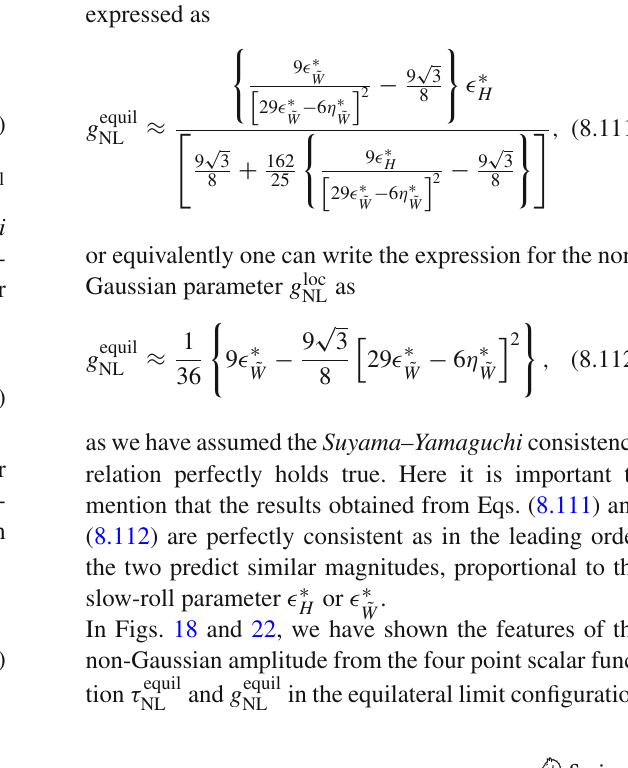
Fig. 18 Representative diagram for equilateral non-Gaussian three point amplitude vs. product of the parameters α ¯ λ in four different regions for = 50 ( red ), N = 60 ( blue ) and N = 70 ( green ) N cmb cmb cmb for the trispectrum for scalar